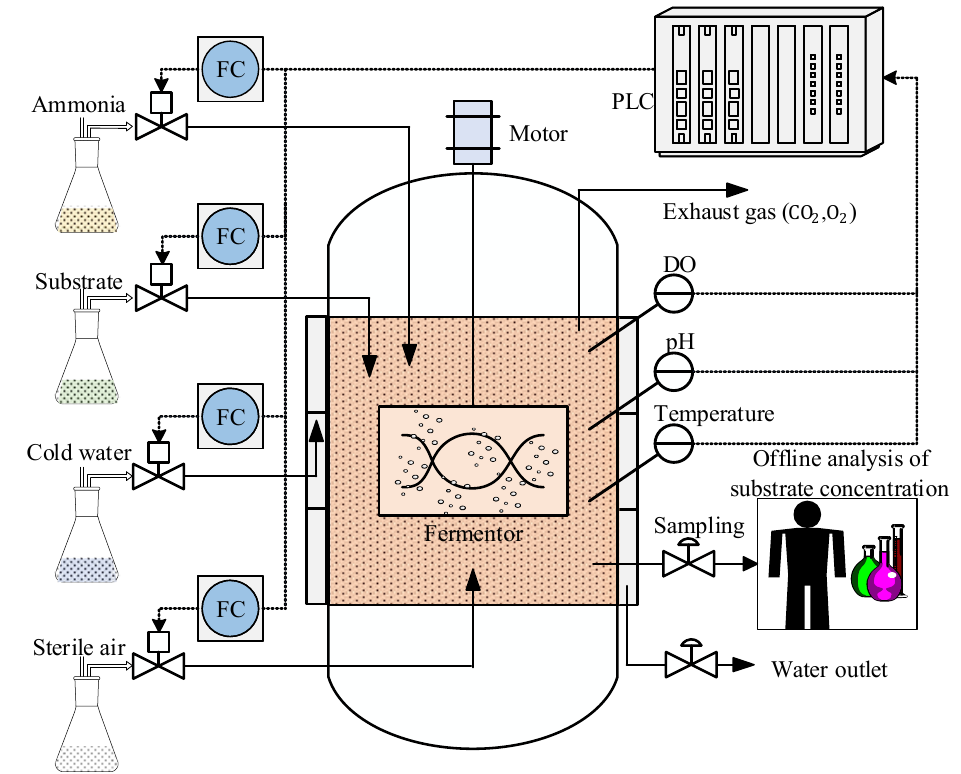
Figure 7. Flowchart of industrial fed-batch CTC fermentation process. In this paper, the CTC fermentation process data from Charoen Pokphand Group are used for model evaluation, where substrate concentration is used as the difficult-to- measure variable and variables listed in Table 6 are used for auxiliary variables. With an online sampling interval of 5 min and offline analysis interval of 4 h, a total of 15 batches of data from the same fermenter were collected for experiments. The first two batches of labeled samples, including a total of 43 samples, are taken as the initial training set, while the remaining 13 batches of data are used for online prediction, including 1015 unlabeled samples and 324 labeled samples. The labeled and unlabeled samples are used for online